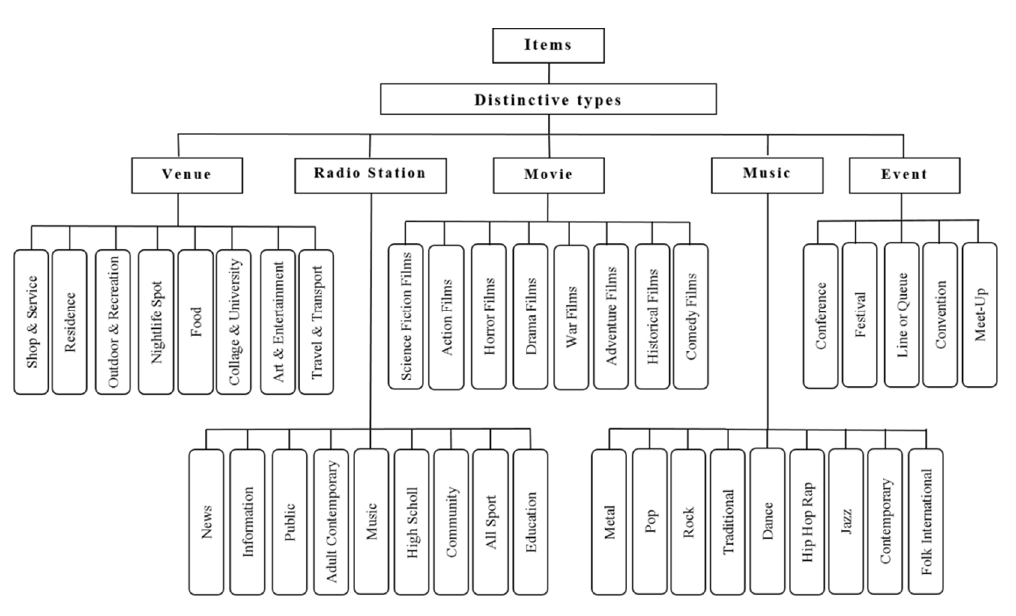
Figure 4. Categorization of different types of heterogeneous items based on their descriptive features